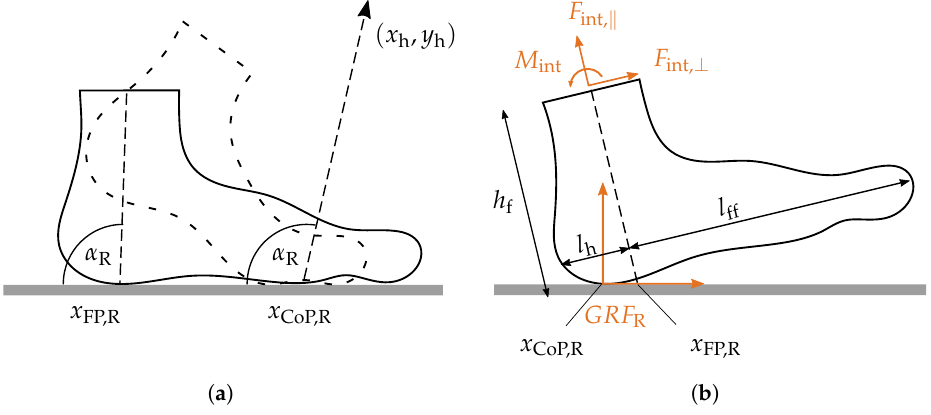
Figure 5. The implementation of the VPP model assumes that the GRFs act at the CoP. The figures were inspired by [23] (reprinted with permission from [23], 2020 Holzberger). ( a ) The implementation assumes a linear shift of the CoP from the heel to the toes depending on the leg angle α R . ( b ) The measured forces F int result from the GRFs. Inertial forces and gravitational forces are